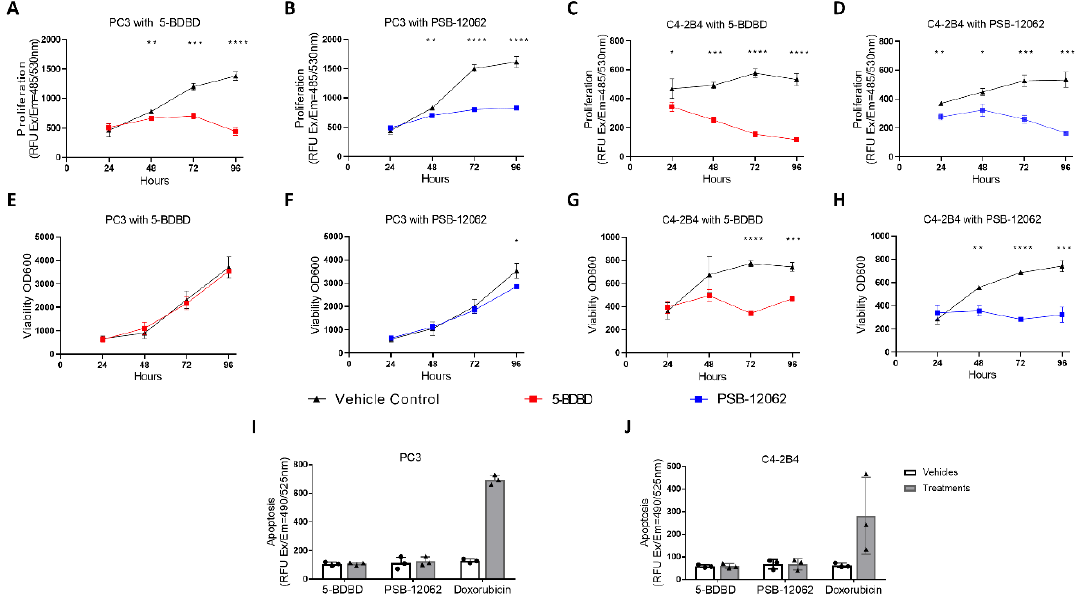
Figure 2. Effects of P2X4R inhibition on PCa proliferation, viability, and apoptosis. The effects of inhibiting P2X4R with specific antagonists (1.0 μM 5-BDBD or 1.5 μM PSB-12062) on the proliferation and viability of PCa cells (PC3 and C4-2B4) up to 96 h were examined by using the ( A – D ) CyQUANT ® cell proliferation assay and ( E – H ) alamarBlue™ cell viability assay. ( I , J ) The apoptotic activity after a 24-h treatment of antagonists or doxorubicin (as a positive control) was measured using the Cell Meter™ Caspase 3/7 apoptosis assay. Data are the mean ± SD, n = three biological repeats, Student’s t -test, * p < 0.05, ** p < 0.01, *** p < 0.001, **** p < 0.0001.